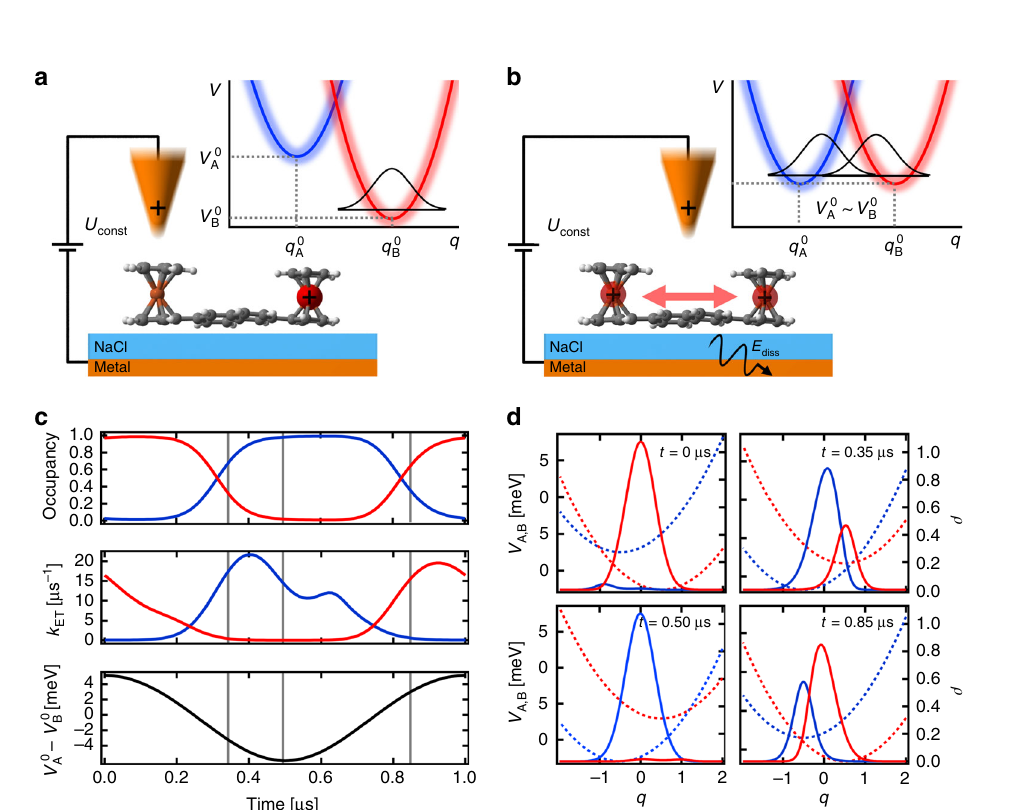
Fig. 2 Experimental detection of the charged state. a – c , d – f A simultaneously taken series of the constant-height frequency shift and dissipation images taken at the same tip-sample distance at three different bias voltages: U = − 3.3 V, U = − 2.5 V and U = 0 V (corresponding to double positively charged molecule, once positively charged molecule and neutral molecule). The scanning area is 3 × 3 nm 2 , oscillation amplitude A = 40 pm for each image, temperature 5 K. g , h Simultaneously taken frequency shift and dissipation x - z images of the characteristic sharp ( “ singularity ” ) line (once positively charged molecule). The vertical cut is 2 × 0.9 nm 2 with the gap of 0.1 nm between the base image and perpendicular image of the singularity line. The perpendicular image is taken with a bias voltage U = − 2.5 V. The base image of bisFc is a constant height frequency shift and dissipation image, taken with a bias voltage U = − 2.5 V (once positively charged molecule). The scanning area is 2 × 2 nm 2 . i Δ f ( z ) charging curves taken at three different positions, see the red, green, and purple lines marked in g and h . All curves are shown after background subtraction and tip-height alignment, as described in Supplementary Methods. j Dissipation signal E diss ( z ) corresponding to Δ f ( z ) spectroscopies. Background dissipation was subtracted. k Effective transfer rates k ET obtained from experiments at two different temperatures, various bias voltages and different tips.